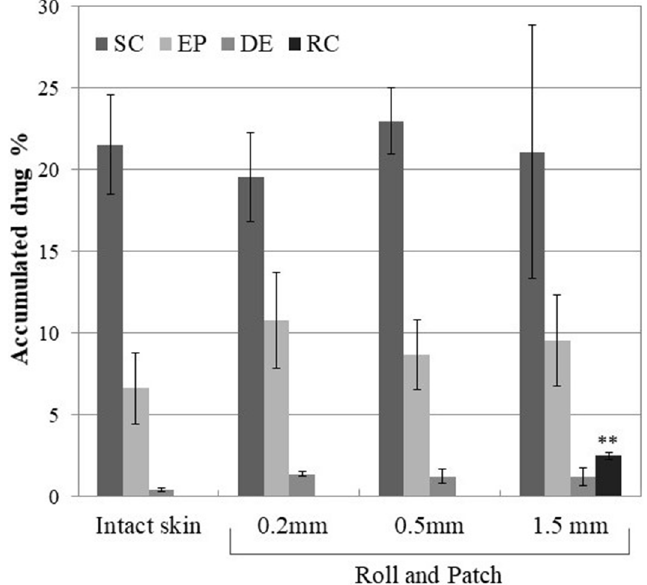
Figure 6. Cumulative amount of DCF retained into and permeated through the skin layers after 8 h treatment with nanosuspension NSP188 and DermaQ ® . The amount is expressed as the percentage of the dose applied on the skin. Roll and Patch: nanosuspension applied after microneedling. SC, stratum corneum; EP, epidermis; DE, dermis; and RC, receptor compartment. ** p < 0.01 vs. Intact skin.